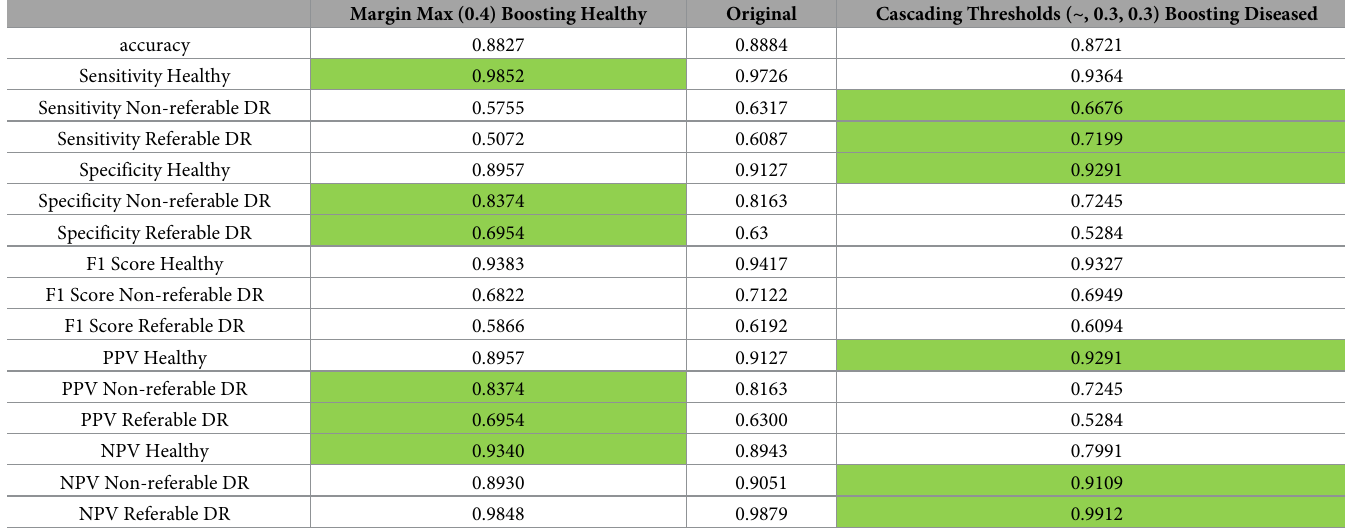
Table 5. Sensitivity boost of the ‘curated’ dataset with three labels, for healthy and diseased categories.